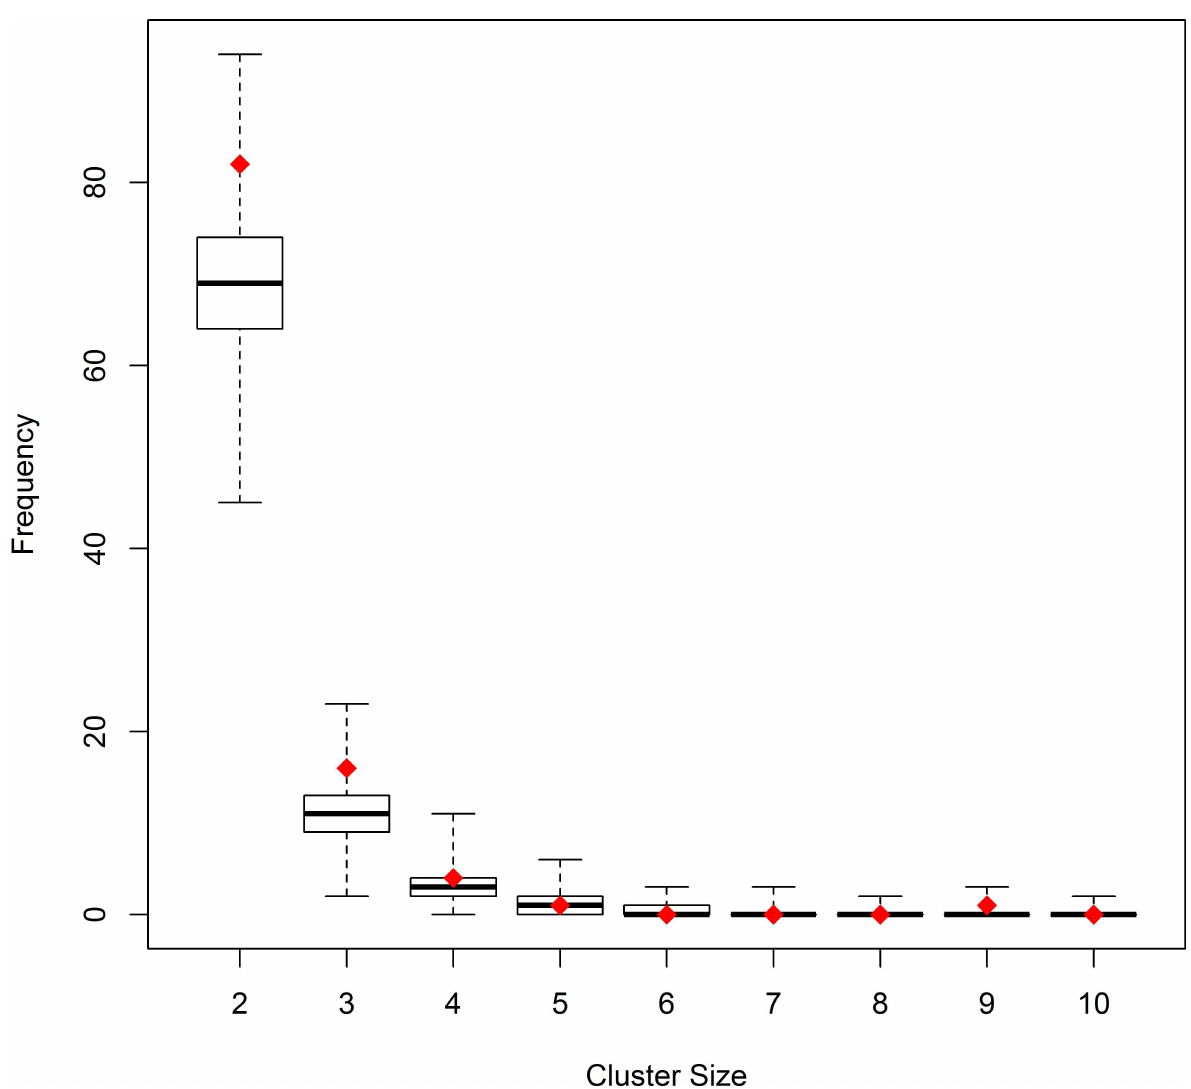
Fig 2. Frequency of clusters of cases of CL by cluster size. Comparisonof the frequencyof clusters of a given size in the empirical data (red diamonds)with the 999 Monte Carlo data sets generatedunder the assumption of no